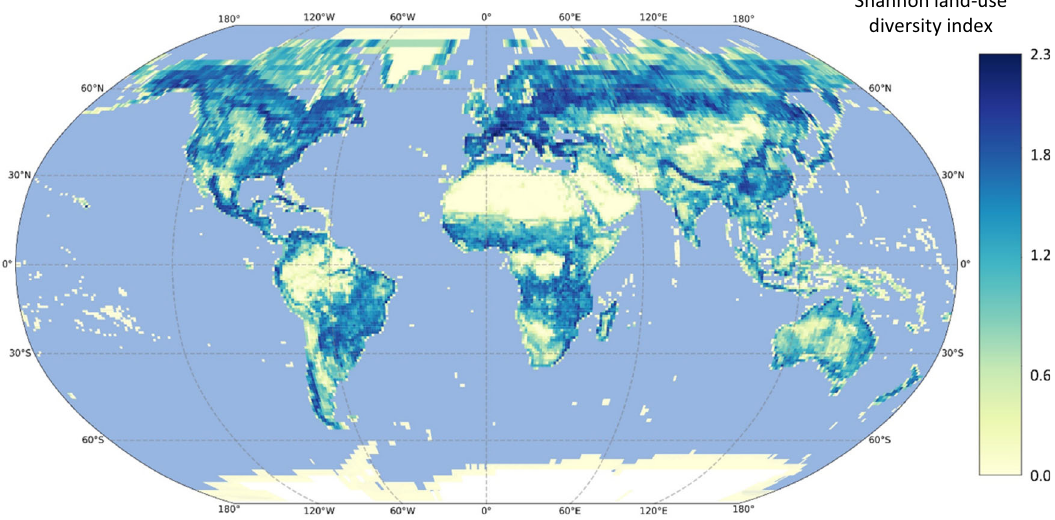
Fig. 1 | Regionalland-use diversityacrosstheworld. Shannon land-use diversity index in each grid cell(one-degree size),calculated from Copernicus Land cover maps (~100m resolution; 2019), which classi fi es land surface in 22 categories of land-use types. Robinson global projection. Base map made with Natural